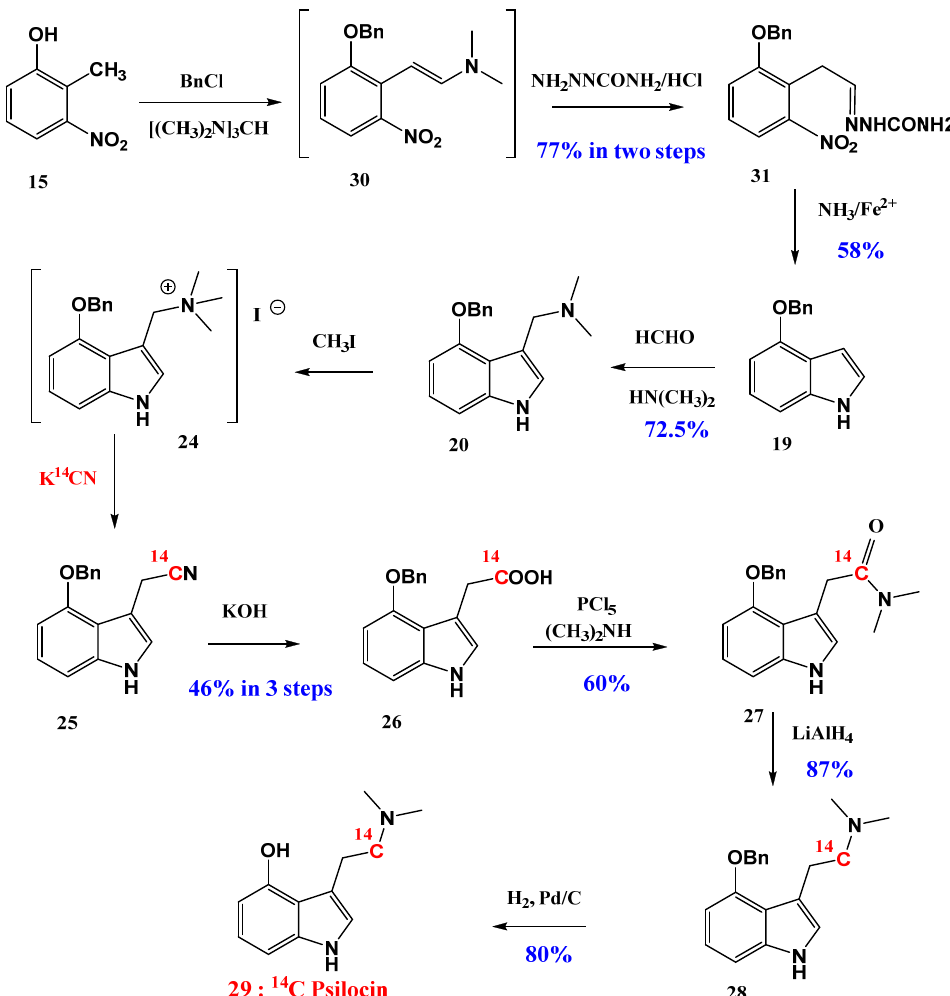
Scheme 11. Improved 14 C-labeled psilocin synthesis by Poon et al. [49]. The synthesis of 3 H-labeled psilocin 34 was obtained by treatment with oxalyl chlo-